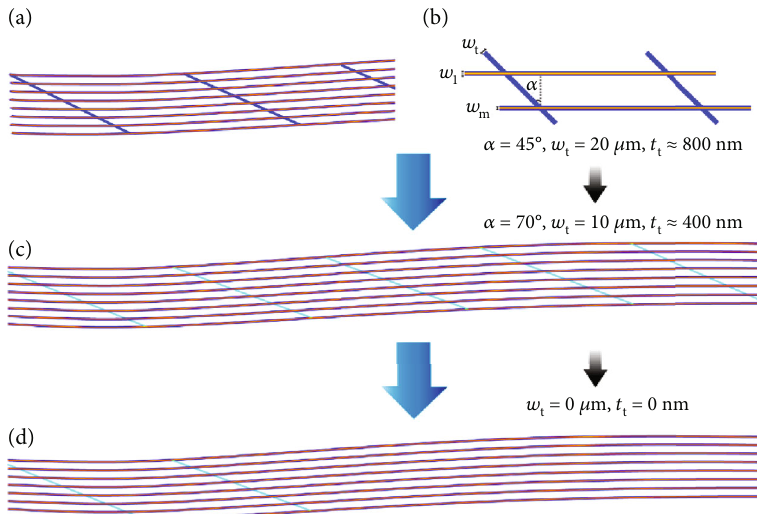
Figure 5: Structural design of ultra fl exible syringe-injectable mesh electronics. (a) Schematic of a conventional mesh electronic probe. (b) Schematic of the mesh electronic unit cell, highlighting key probe design parameters, including the angle between longitudinal and transverse elements ( α ), the longitudinal element width ( w l ), the transverse element width ( w t ), the longitudinal interconnect metal width ( w m ), and the transverse element thickness ( t t ). For the standard mesh ( α = 45 ° , w l = 20 μ m, w t = 20 μ m, w m = 10 μ m, and t t ≈ 800 nm). (c) Schematic of ultra fl exible 2D mesh electronics to facilitate loading and injection using reduced diameter needles and injection volumes, where α = 70 ° , w t = 10 μ m, and t t ≈ 400 nm; parameters for the longitudinal elements are the same as in the standard design highlighted in panel (b). (d) Schematic of ultra fl exible 1D mesh electronics with transverse element removal in the implantation site, i.e., w t and t t equal to zero, and the parameters for the longitudinal elements and transverse elements external to the implantation region are the same as the 2D probes highlighted in panel (c). Orange lines represent the gold interconnects, dark blue lines represent two SU-8 layers for interconnect insulation, and the cyan line represents a single SU-8 layer